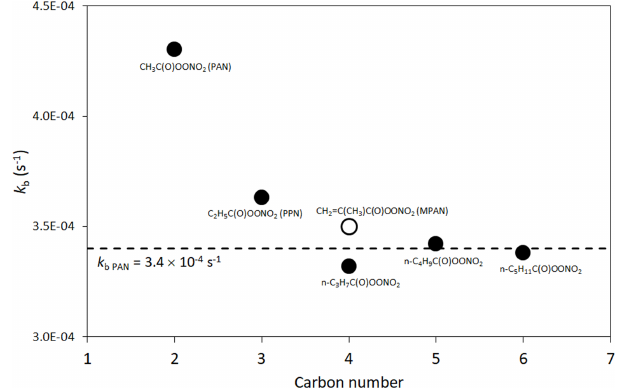
Figure 1. Reported thermal decomposition rates of selected per- oxyacyl nitrates at 298K and 760 Torr. Values for PAN, PPN and MPAN (defined in the figure) are the IUPAC Task Group recom- mendations (http://iupac.pole-ether.fr/, last access: January 2019). The other values are taken from the systematic study of Kabir et al. (2014), which also reports consistent values for PAN and PPN. The broken line is the generic rate coefficient, k bPAN , for the de- composition of RC(O)OONO 2 structures (see Sect. 2.2 and Ta- ble